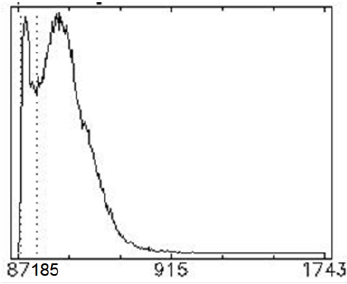
Figure 2. The histogram of brightness (i.e., the mean of the three bands, NIR, red and green), calculated using pixels as statistical units. A bimodal histogram splitting method was used to determine the optimum threshold value of 185 for separation of shaded pixels from non-shaded pixels.